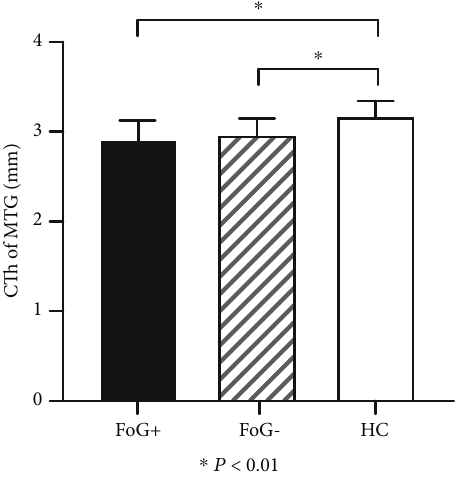
Figure 2: Comparison of CTh of right middle temporal gyrus (MTG) between groups. CTh was lower in PD FoG+ group and FoG- group compared with HC, but no signi fi cant di ff erence between two groups of PD subjects.